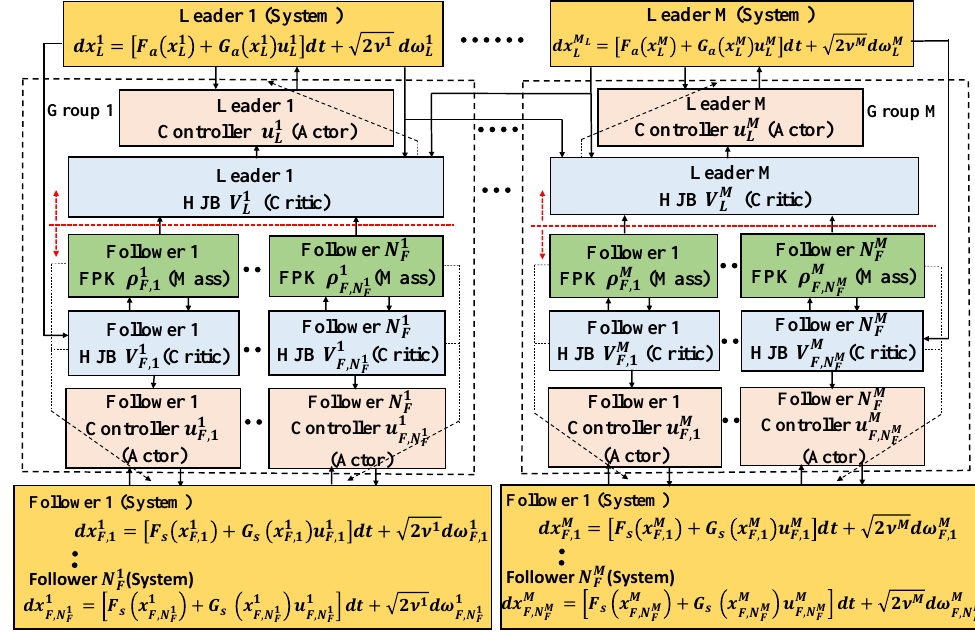
Figure 2. Mixed game-based hierarchical learning